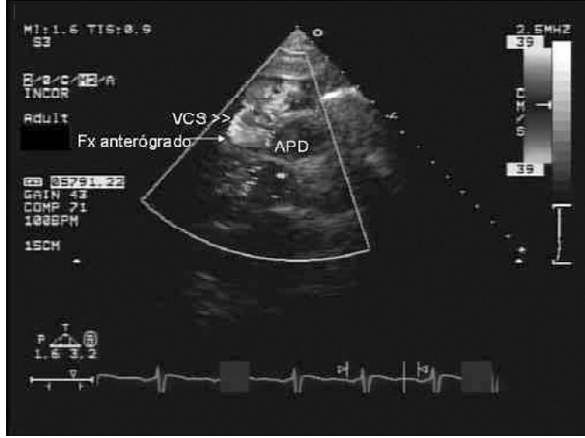
Fig. 1 – Ecocardiograma transtorácico com mapeamento de fluxo em cores pré-operatório mostrando competição de fluxo entre o fluxo anterógrado pulmonar e da veia cava